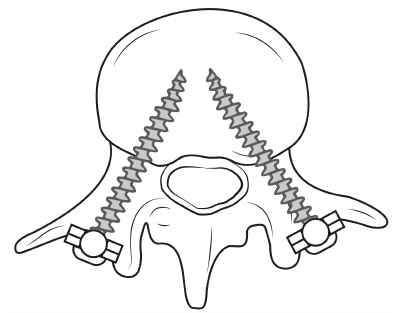
Figure 1. Schematic illustration demonstrating PSP within a lumbar